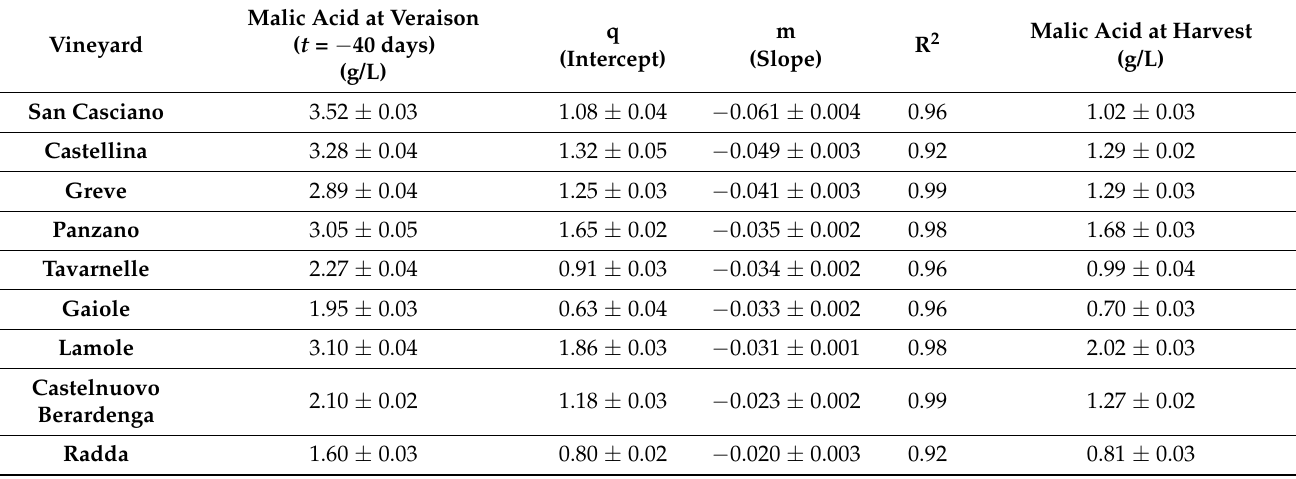
Table 7. Calculated values of the functional parameters, intercept, slope and R 2 of the malic acid concentration inside the grapes coming from the different vineyards.